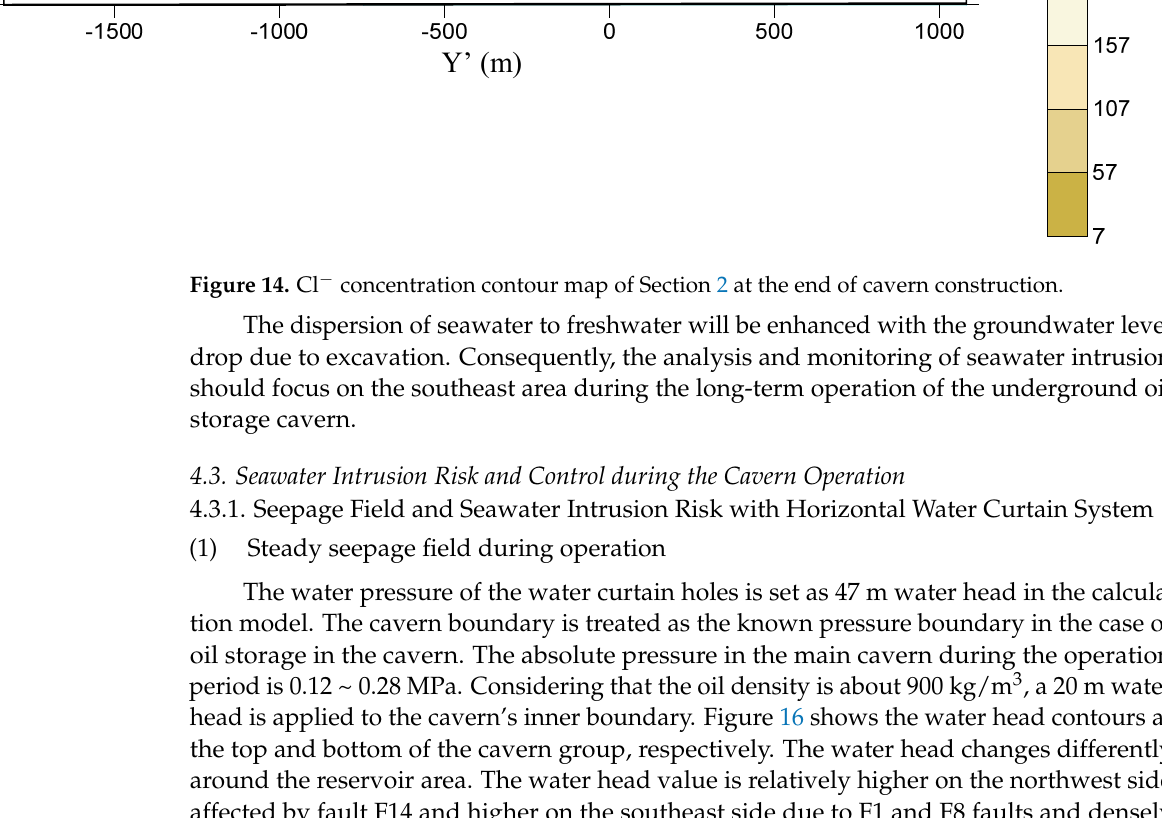
Figure 15. Cl − concentration contour at − 80 m elevation at the end of construction.